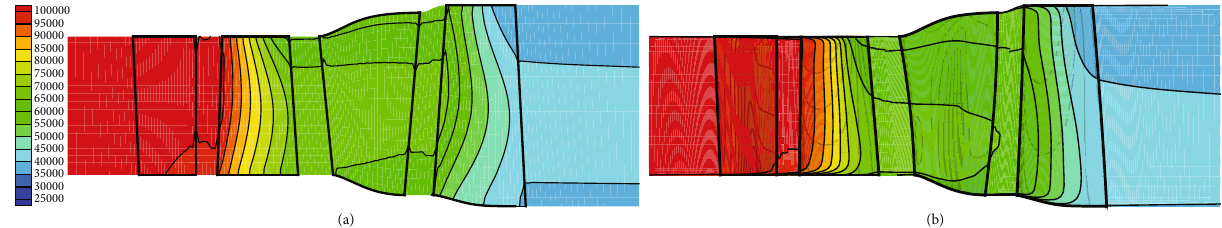
Figure 10: Total pressure of the two-stage turbine: (a) Q3D; (b) 3D.